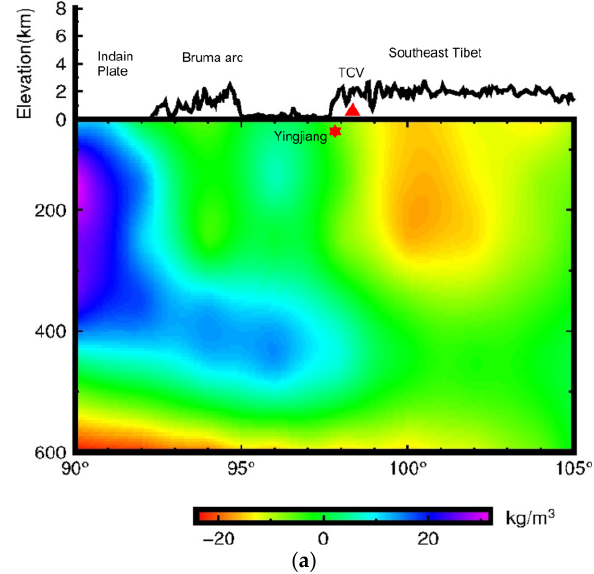
Table 2. Key parameters of the earthquakes involved in this